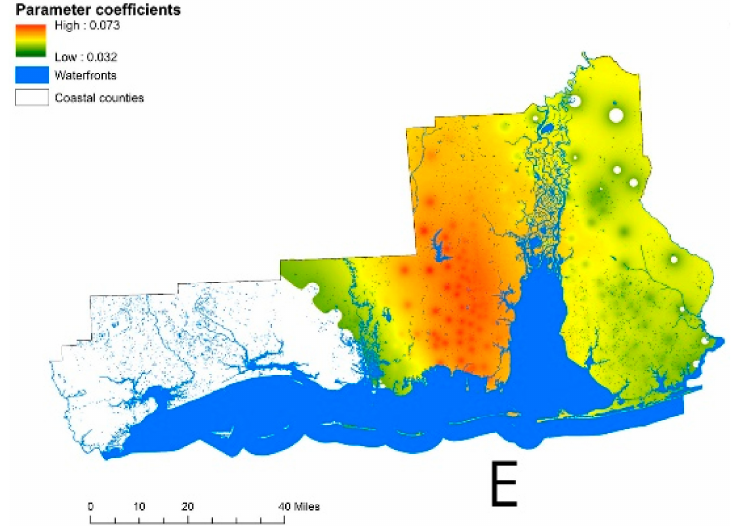
Figure 4. Local parameter coefficients of proximity to waterfront ecosystem services estimated from GWR model that were statistically significant at 10% or a better significance level: ( A ) bay, ( B ) stream, ( C ) river, ( D ) other water body, and ( E )